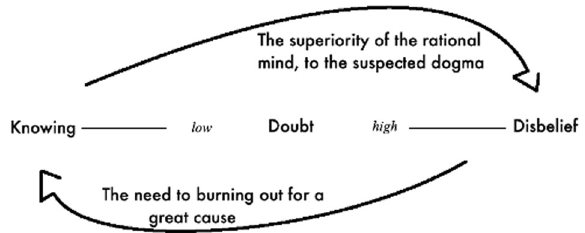
Fig. 2 Two opposing impulses. These impulses indicated by two arrows, contribute to the change of the skeptic ’ s respect to